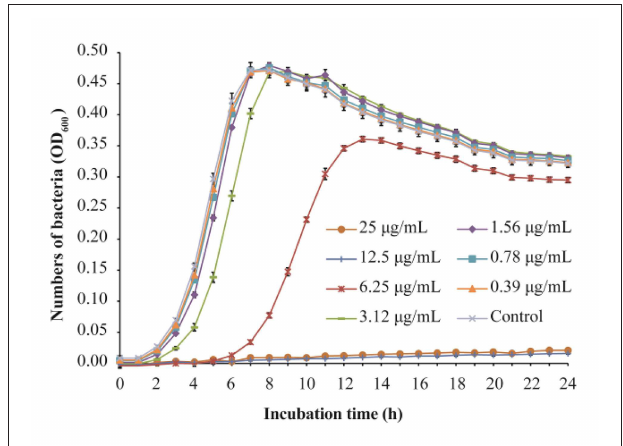
FIGURE 1 | Growth of Listeria monocytogenes ATCC 19115 culture in tryptic soy broth supplemented with various concentrations of thymoquinone (TQ). Bars indicate the standard deviation ( n = 6).